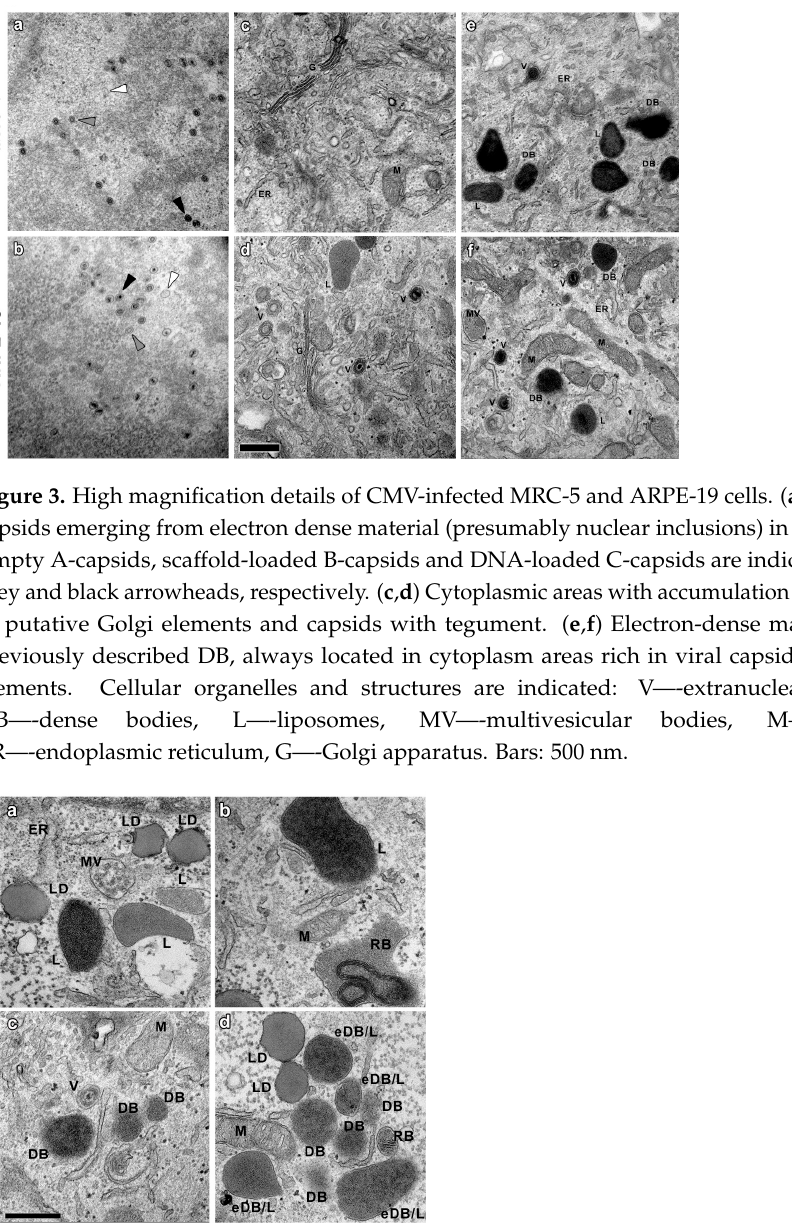
Figure 4. CMV DB identification. Comparison of cellular organelles and DB. ( a , b ) highlight structures found in mock infected ARPE-19 cells, most of them related with the cell endocytic processes. Lysosomes(L) are relatively electron-dense membrane-bound organelles, usually spherical and homogenously filled with tiny granules. Multivesicular bodies(MV) are round or oval cell organelles, usually containing an electron- lucent matrix, with small vesicles (diameter between 40 to 150 nm), also limited by adoublemembrane. Residual bodies (RB) or telolysosomes are surrounded by a membrane with very electron-dense granular content due to thefatty component of the lipofuscin(an aging pigment). Lipid droplets (LD) are composed of a neutral lipid core surrounded by a phospholipid monolayer. Note that all of them are membranous organelles. A mitochondrion (M) and endoplasmic reticulum (ER) were also detected. ( c , d ) show structures that can be found in infected ARPE-19 cells. In addition to all the previously described cellular organelles, DB structures, not present in mock samples, are identified. DB are similar in electron density to most of the lysosomes, but in many cases, with absence of membrane, and always surrounded by viral particles. Assemblies that were compatible with either enveloped DB or Lysosomes (eDB/L) were also detected. Bars: 500